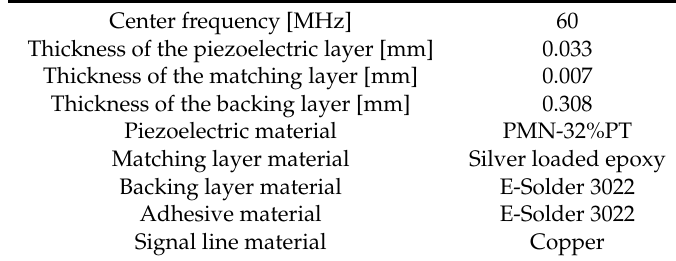
Figure 2. Geometric models of the four designed transducers used for finite element analysis (FEA) simulation: ( a ) Ideal transducer #1; ( b ) conventional transducer; ( c ) ideal transducer #2; and ( d ) proposed transducer. Table 1. Common design specifications of four transducers used in FEA simulation.